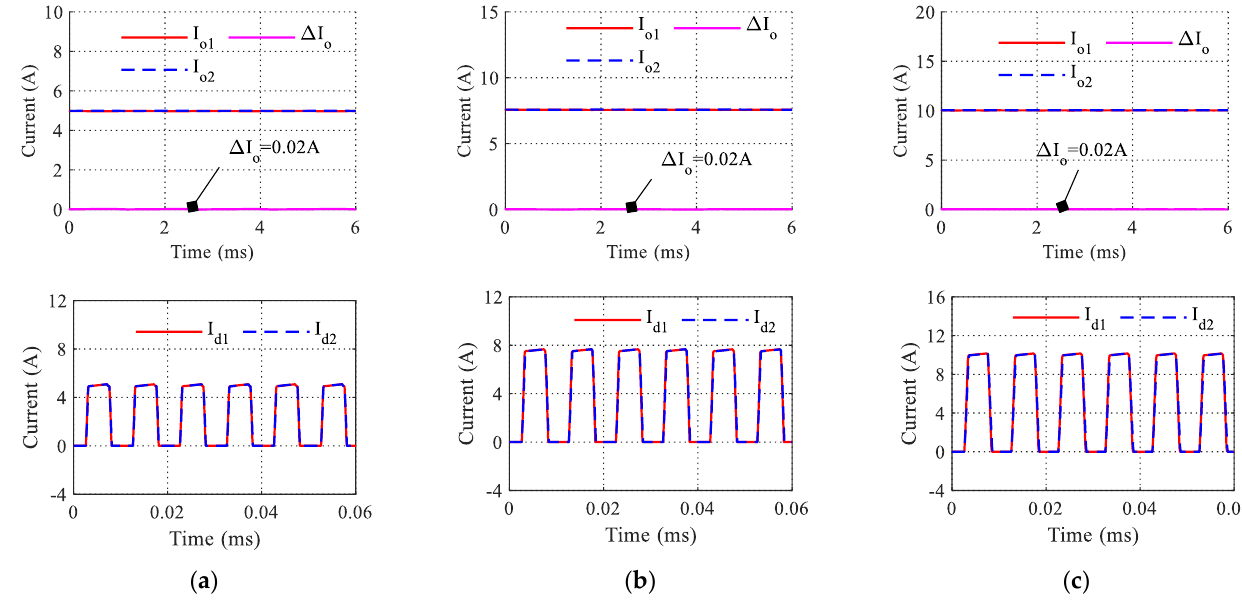
Figure 16. Simulation result of Figure 16. Simulation result of I o and I d in different P o after using DHC when a = 1.2; ( a ) R o = 4 Ω , P o = 400 W; ( b ) R o = 2.667 Ω , P o = 600 W; ( c ) R o = 2 Ω , P o = 800 W. Table 5. Data comparison of different output power after using DHC when a = 1.2. Table 5. Data comparison of different output power after using DHC when a =